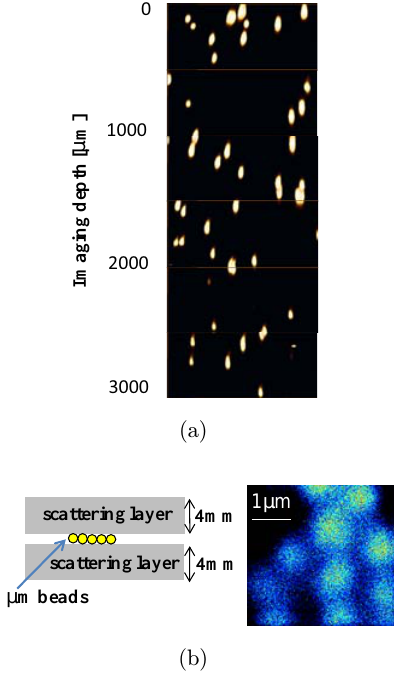
Fig. 2. 3D image reconstruction of 2 (cid:1) m beads embedded in scattering silicone resin (a). Image of 1 (cid:1) m beads sandwiched between two 4-mm thick scattering silicone slices (b). The Olympus XLSLPLN25XSVMP microscope objective was used to acquire image (b).